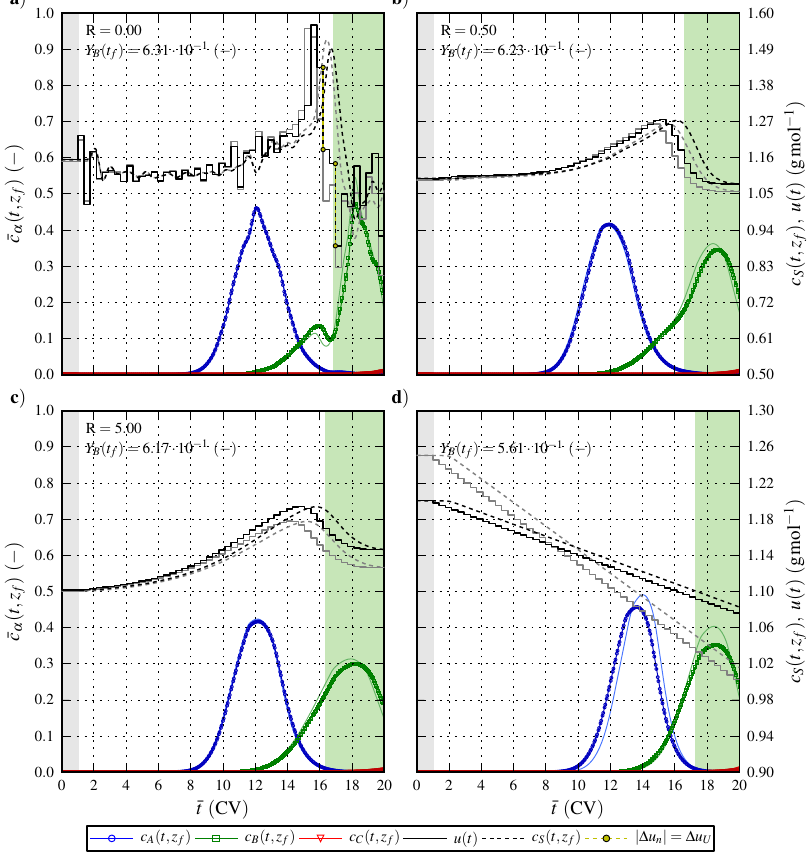
Figure 10. Nominal and robustified state and control trajectories. Markers indicate the robustified solution at the Radau collocation points and solid and dashed lines the corresponding simulated response. The light colored state and control trajectories indicate the nominal